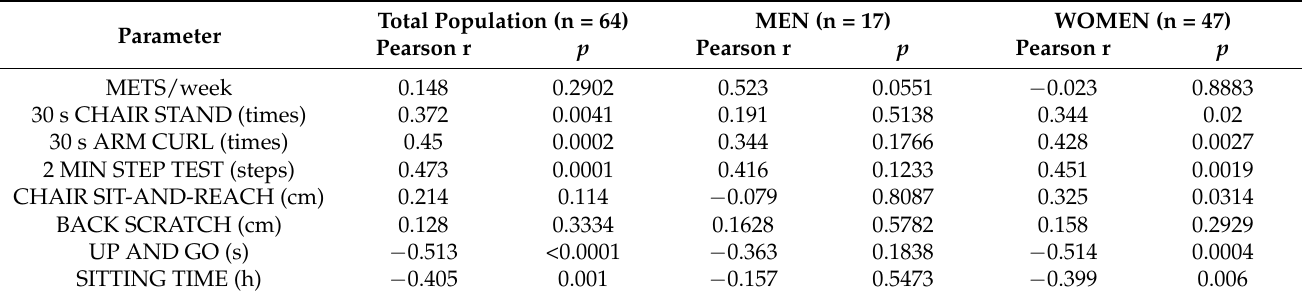
Table 6. Correlation between blood plasma CoQ 10 and scores in the SFT.